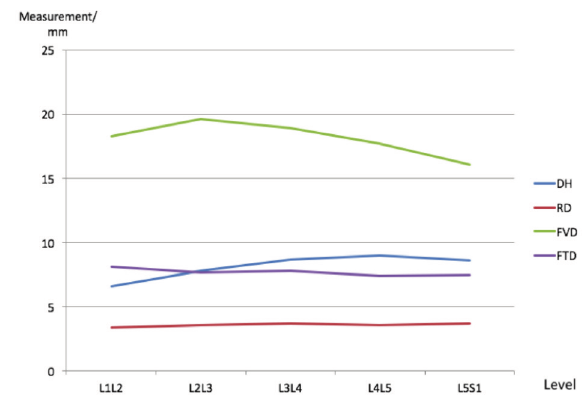
Measurements of the disc vertical diameter (DVD), nerve Fig. 2: root diameter (RD), foraminal vertical diameter (FVD) and foraminal transverse diameter (FTD) of the lumbar spine.